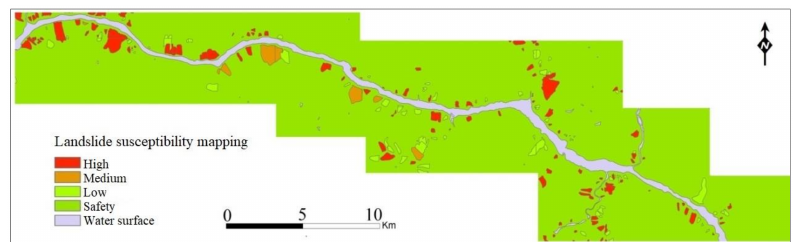
Figure 5. Landslide susceptibility mapping in Zigui–Badong County near Three Gorges Reservoir based on the 4 degrees of spatial development of landslides, the C5.0 decision tree algorithm with image segmentation, and geological factor evaluation, which yields good classification results.